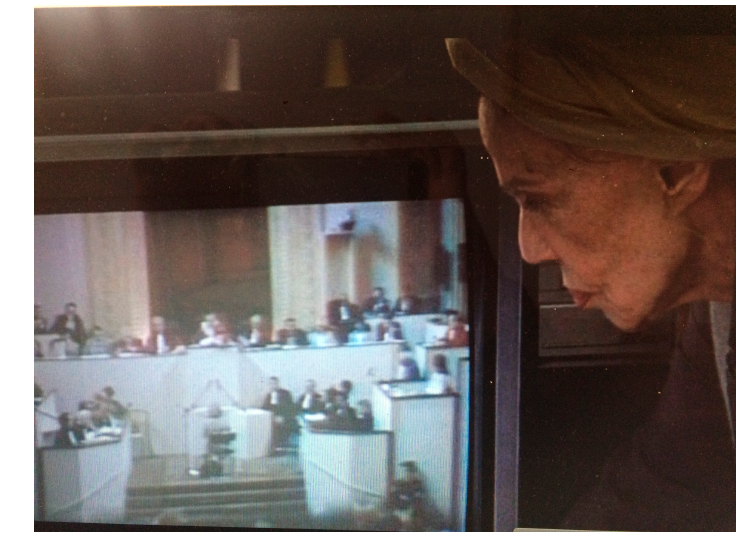
Figure 1. Testimony of Lea Katz.